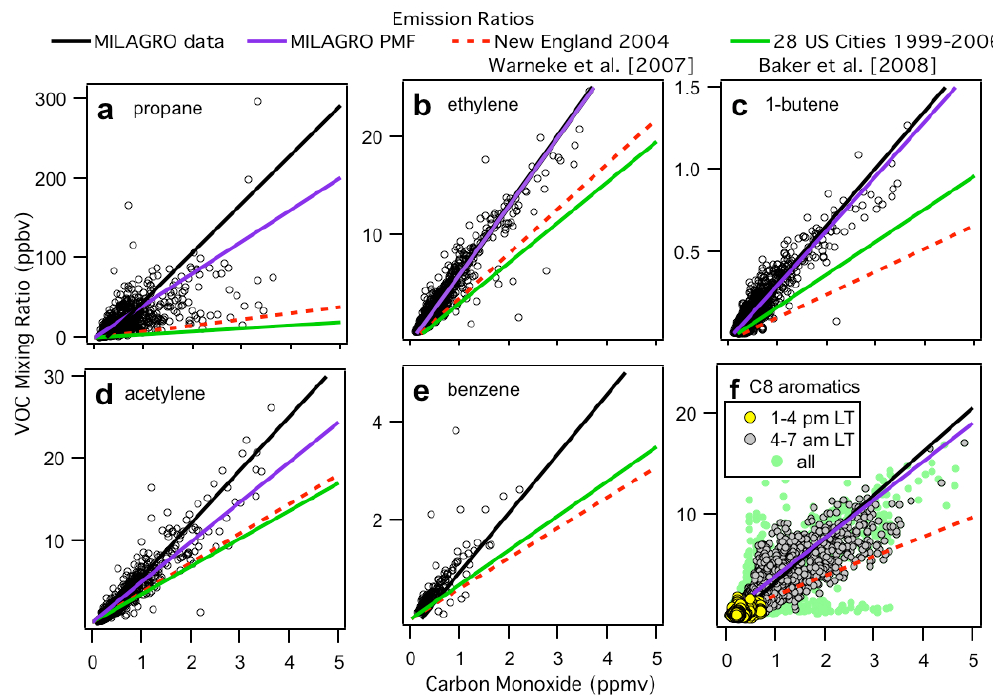
Figure 7. Selected plots used to calculate urban emission ratios (ERs) with respect to carbon monoxide (CO) for VOC measurements made by GC-FID (a–d) , canister samples (e) and PIT-MS (f) . Urban ERs calculated from measurements using ODR fits (black) and Positive Matrix Factorization results (purple) during MILAGRO. MCMA ERs are compared to literature values (red, green) obtained for cities in the United States. PIT-MS measurements are shown on a 1-minute time base (f) to highlight mixing ratio differences prior to local sunrise (grey) versus those observed during the mid-afternoon (yellow). PMF lines represent ERs obtained by summing the traffic and LPG factors.